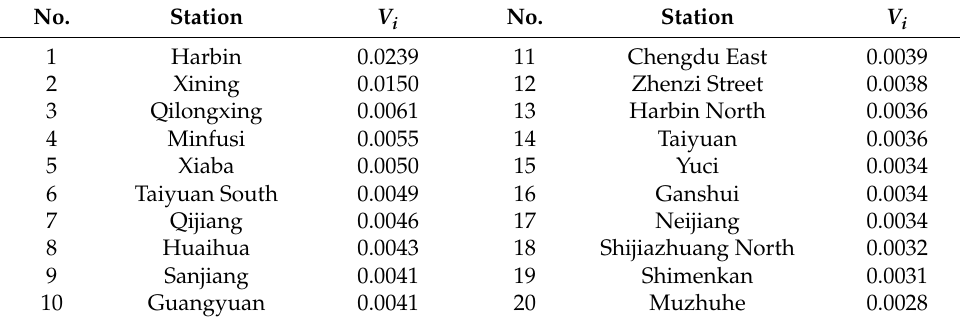
Table 5. Important stations in the geological railway